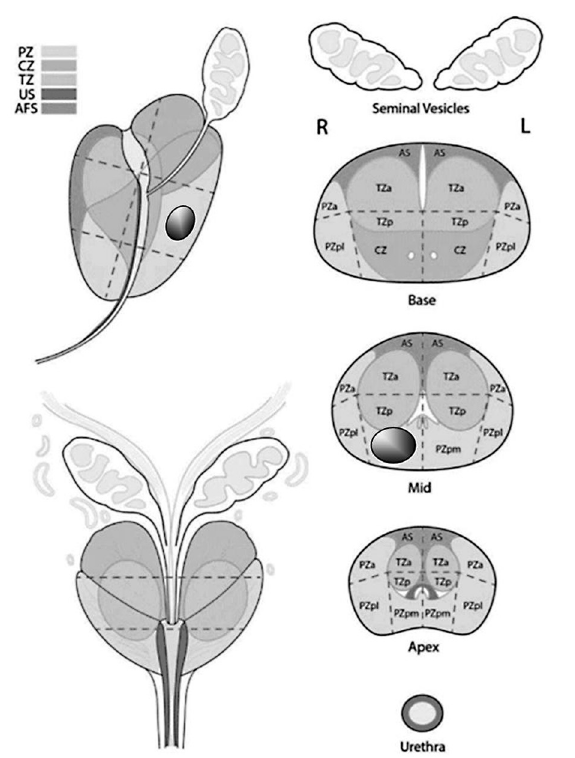
Figure 2 - PI-RADS anatomic division document with marked suspicious PI-RADS 4 lesion in the right posteromedial peripheral zone at the midgland level.